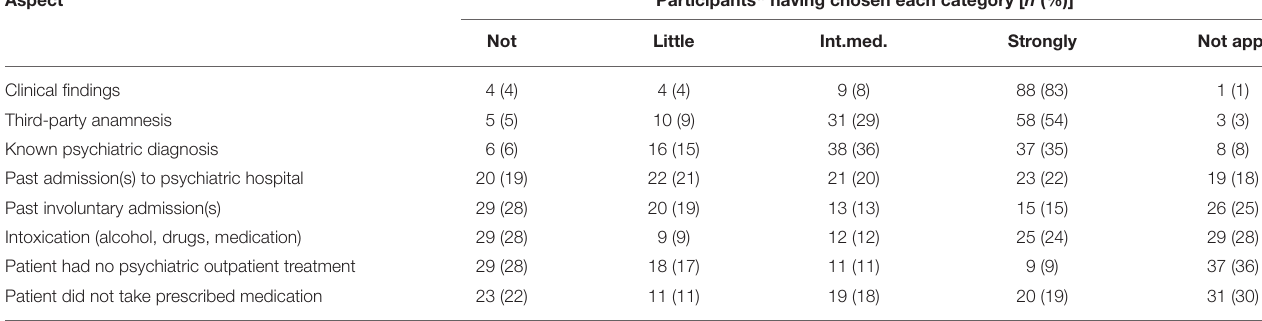
TABLE 5 | Contribution of different aspects to the decision for IA. Aspect Participants a having chosen each category [ n (%)] Not Little Int.med. Strongly Not